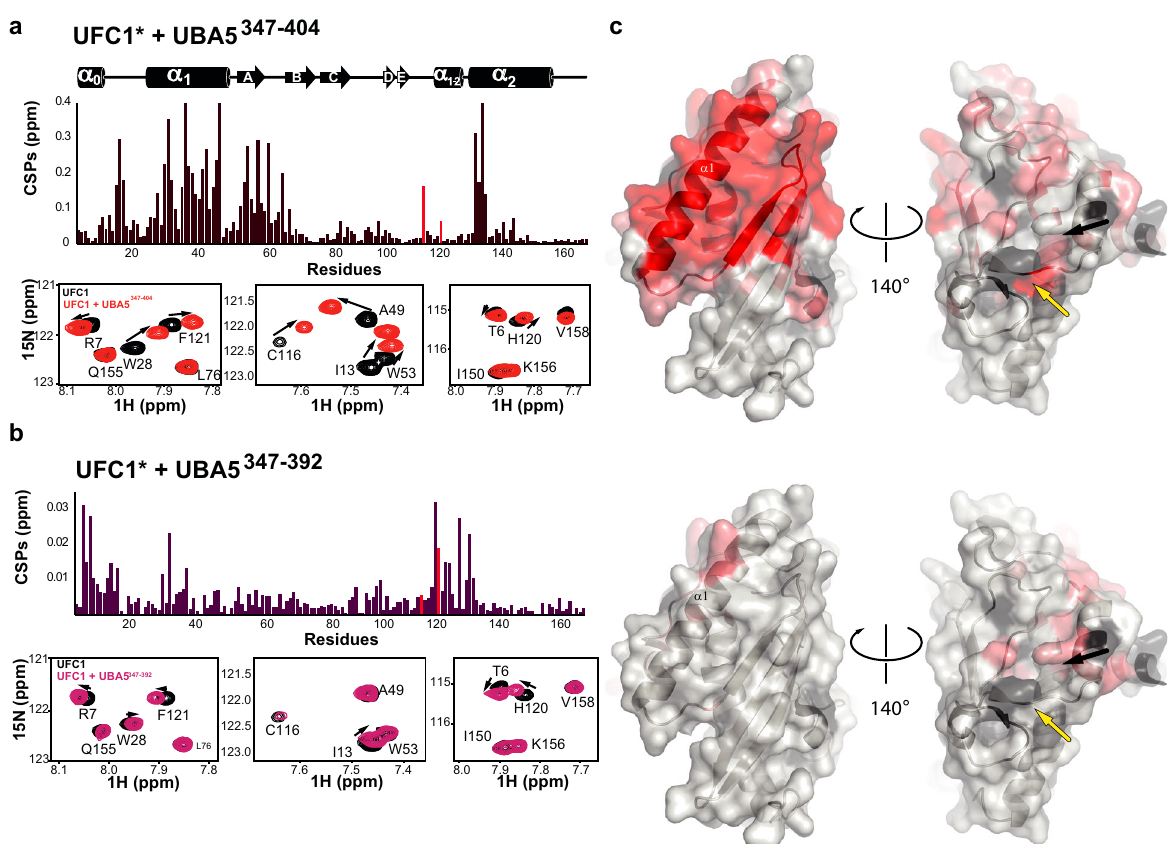
Fig. 6 UBA5 linker affecting UFC1 active site Cys. a – b Chemical shift perturbations (CSPs) of 0.2 mM 15 N-labeled UFC1 upon addition of equimolar concentration of UBA5 347 – 404 ( a ) or fi ve molar equivalents of UBA5 347-392 ( b ). Bars correspond to UFC1 active site C116 and F121 are colored in red. Select regions of 1 H – 15 N HSQC spectra showing the spectrum of 0.2 mM UFC1 alone (black) and in the presence of an equimolar concentration of UBA5 347-404 (red; a , bottom row) or fi ve-fold excess of UBA5 347-392 (purple; b , bottom row) c Structure of UFC1 (pdb 2Z6P) with the residues displaying signi fi cant CSPs (>0.04 ppm) upon interaction with UBA5 347-404 (upper panel) or UBA5 347-392 (>0.008 ppm; lower panel) colored in light red. For upper panel residues with CSPs value greater than 0.08 ppm are highlighted in red. Yellow and black arrows indicate the positions of UFC1 active site C116, or UFC1 F121,